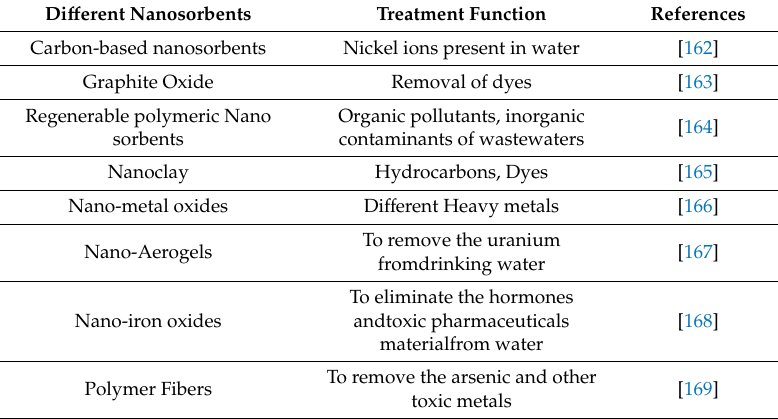
Table 5. Most commonly used nanosorbents and their